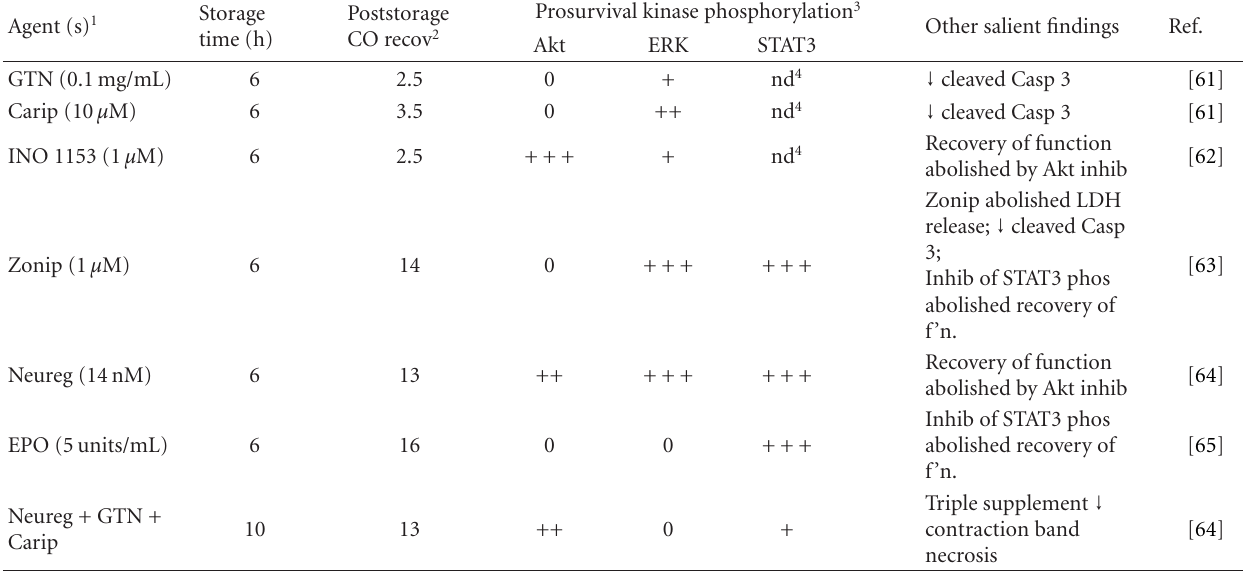
Table 3: Pharmacological activation of prosurvival kinases in a model of donor heart